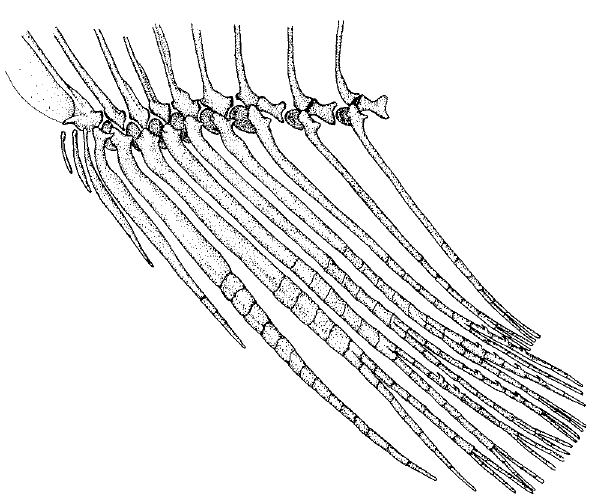
Fig. 5. Bryconadenos tanaothoros , new species, paratype. USNM 352061, SL 34.7 mm, adult male. Lateral view of left side of anterior region of anal fin showing fusion of pterygiophores and respective medial radials of anterior five branched rays. Note that the pterygiophores lack anterior and posterior median blades for the origin of the erectors and depressors anales muscles. Brazil: Mato Grosso; tributary to rio Suiazinho near Ribeirão